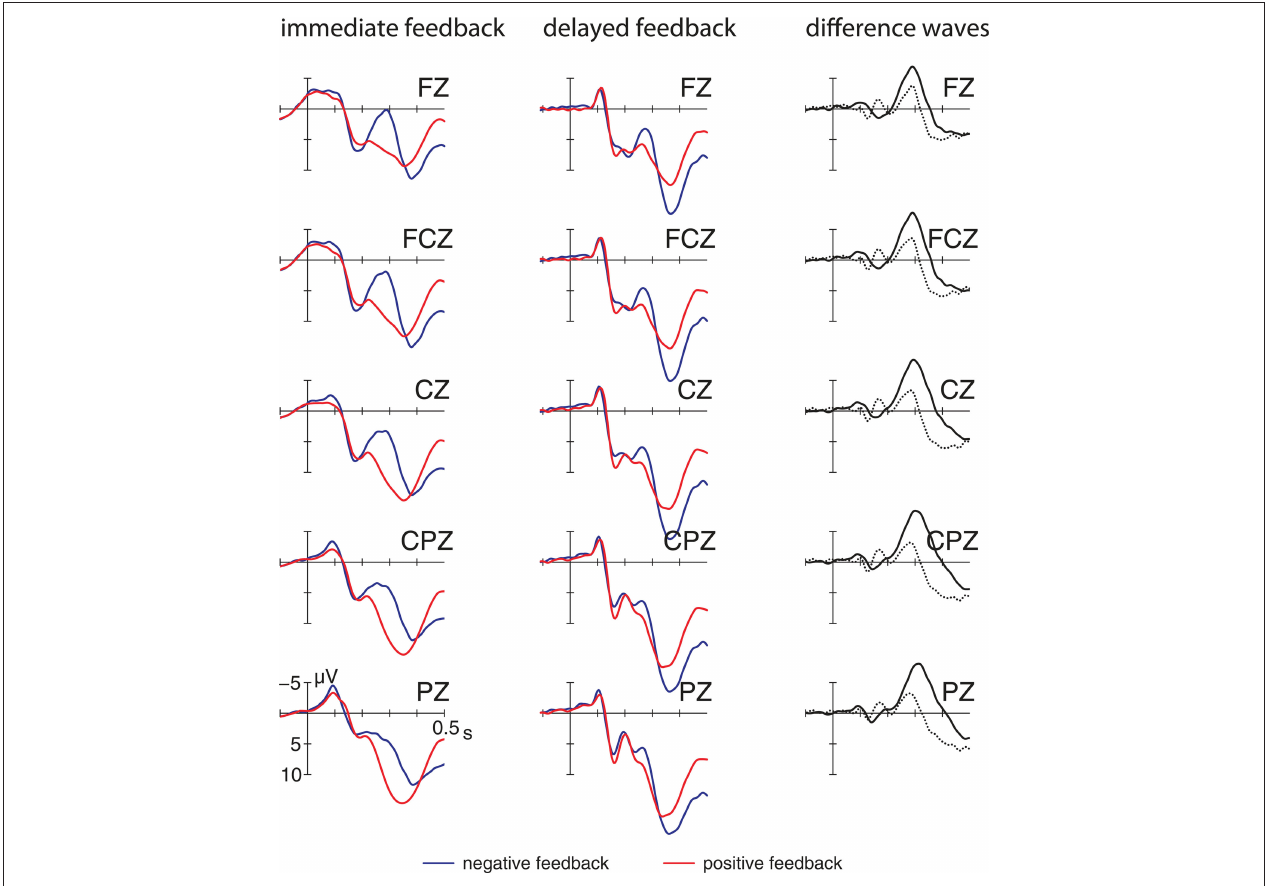
FiguRE 2 | Event-related potentials at midline electrodes elicited by positive and negative feedback when feedback was provided immediately (left column) or with a delay (middle column). The right column displays the difference waveforms (negative–positive) for both feedback conditions. solid line – immediate feedback, dotted line – delayed